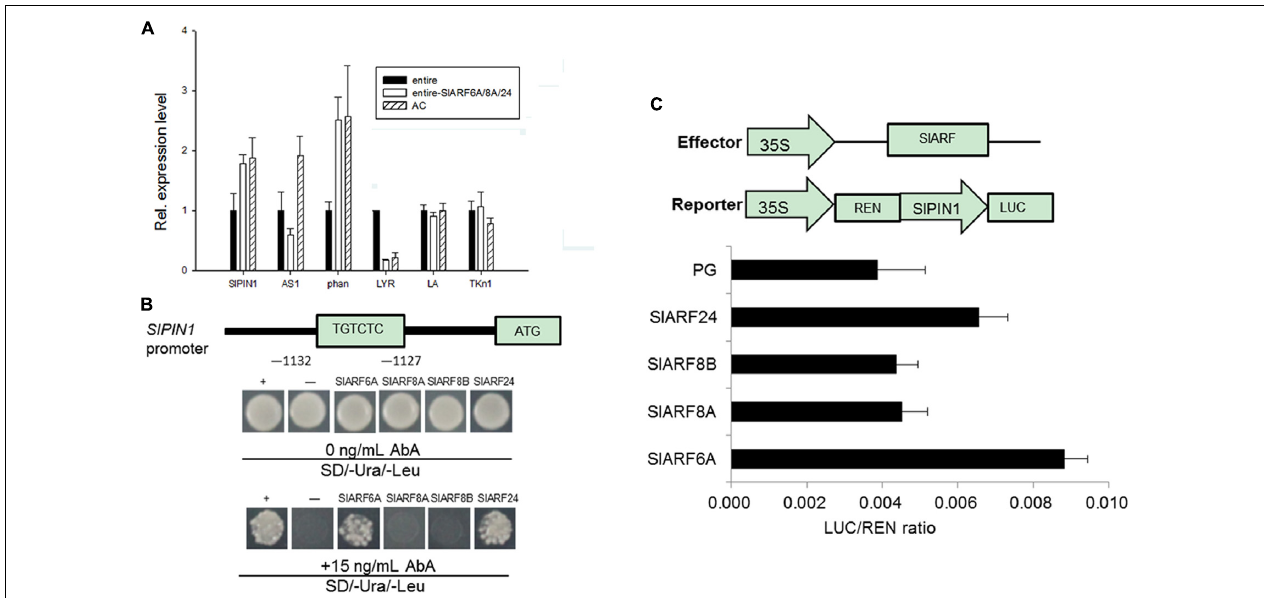
FIGURE 5 | Quantitative real-time PCR analysis of leaf shape related genes and SlARF6A and SlARF24 bind to the SlPIN1 promoter. (A) The expression of SlPIN1 , AS1, and phan in the leaves of e mutant, silencing of all the four SlARF genes materials and wild type plants. (B) Yeast-one hybrid (Y1H) assay of SlARF6A and SlARF24 binding to SlPIN1 promoter. The yeast cells grown on SD/-Ura/-Leu and SD/-Ura/-Leu + 15 ng ml − 1 AbA. (C) Transcription activity assay in tobacco to examine the interaction between candidate SlARFs and SlPIN1 promoter. The schematic diagrams constructs used for the dual LUC assay; REN ( Renilla luciferase ), a control for activity normalization; PG, the empty vector of pGreen II 62-SK. Standard errors (SE) are shown ( n = 3).